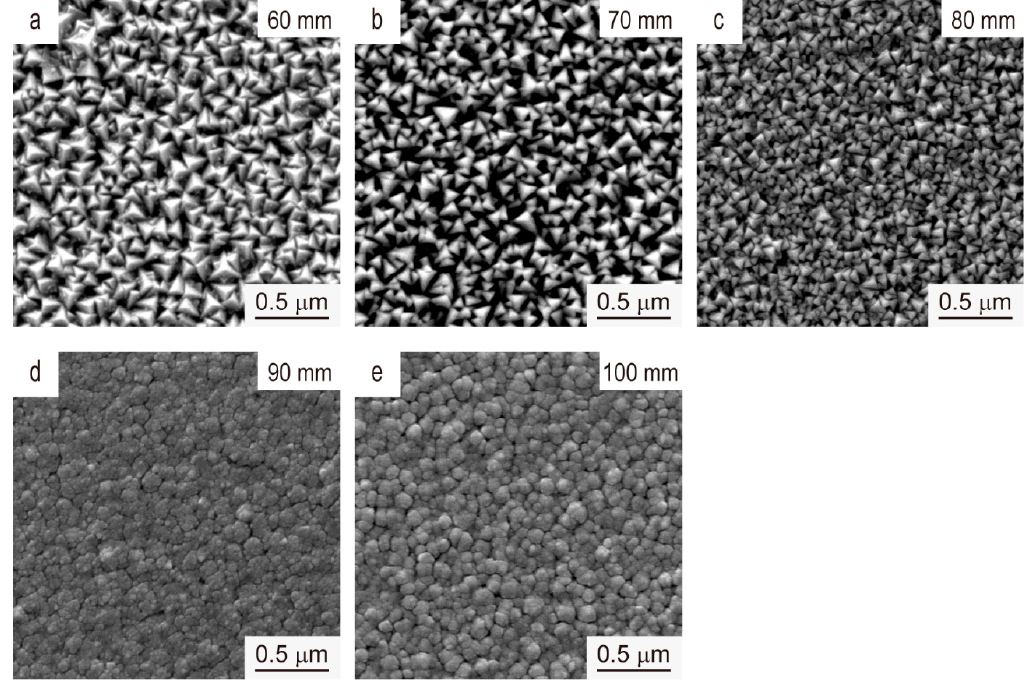
Figure 6. SEM images of the V films deposited on Si (100) at T s = 400 ◦ C, D t-s = ( a ) 60 mm, ( b ) 70 mm, ( c ) 80 mm, ( d ) 90 mm, and ( e ) 100